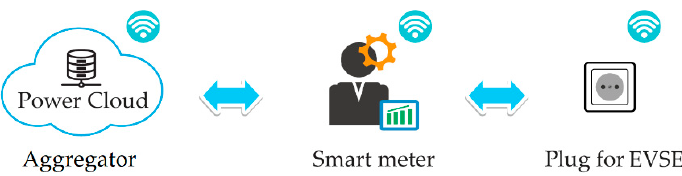
Figure 4. Sending a command, receiving an answer: from aggregator to smart meters.